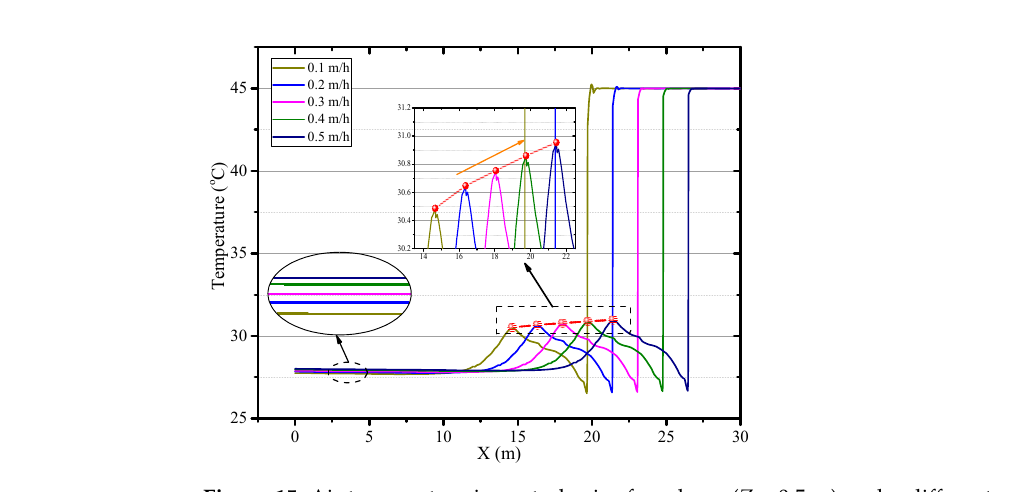
Figure 15. Air temperature in central axis of roadway ( Z = 0.5 m) under different advance rate of the working face.